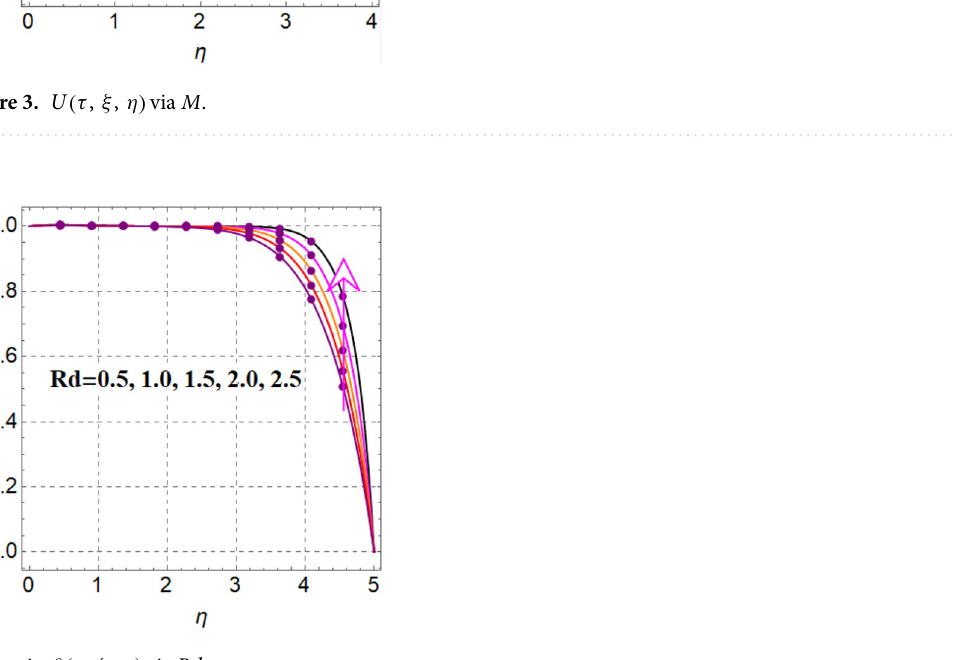
Figure 4. θ(τ , ξ , η) via Rd